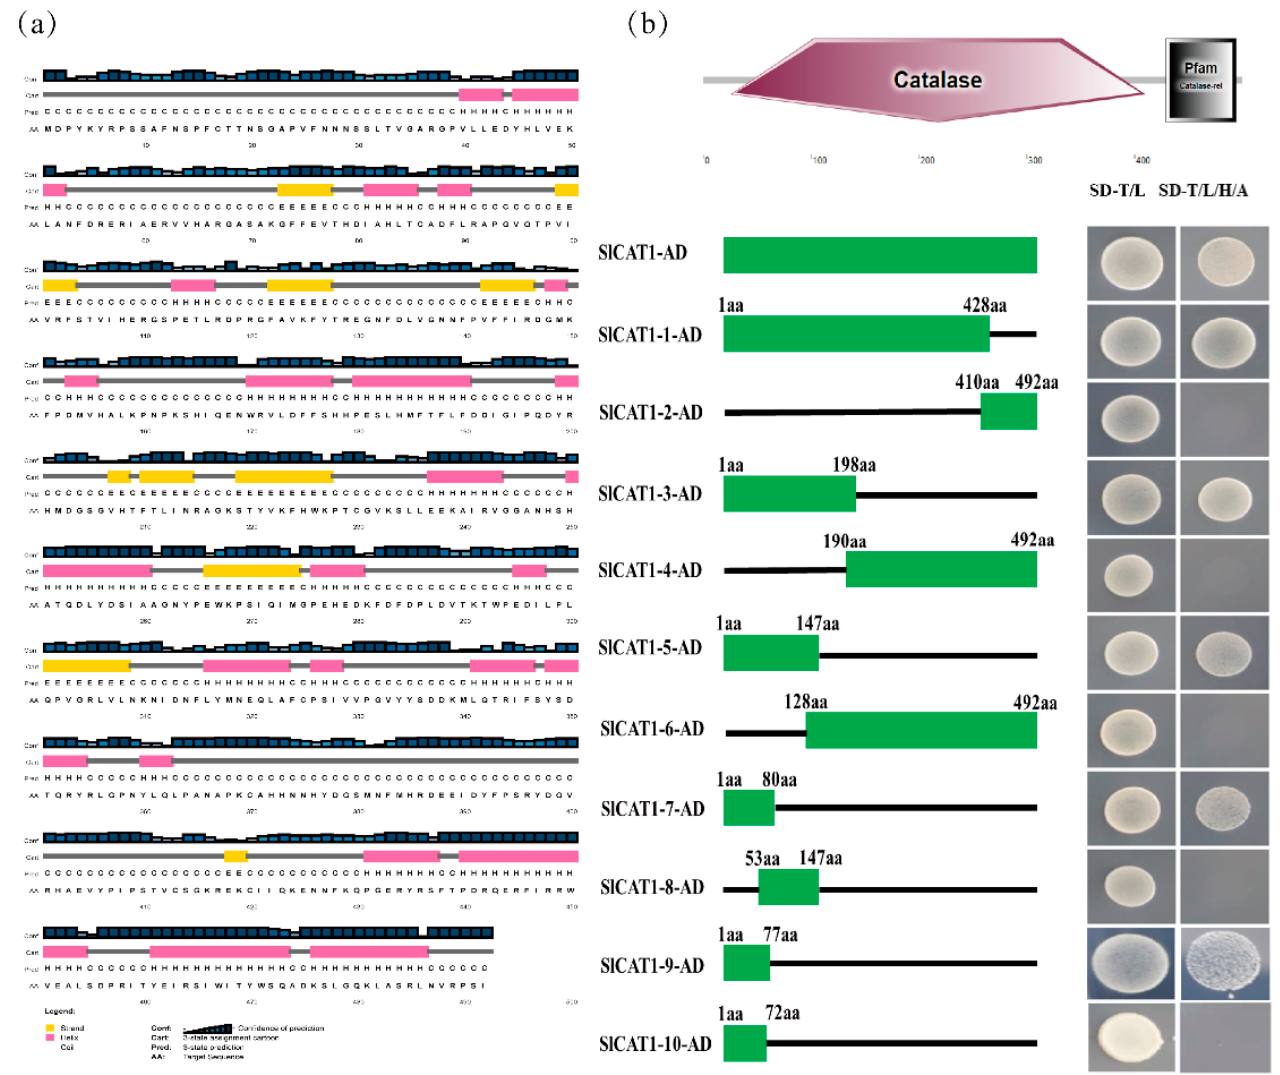
Figure 4. Verification of the functional region of the yeast cotransformation and the p27 interaction. ( a ) Prediction of the secondary structure of SlCAT1. ( b ) Prediction of the SlCAT1 domain, and Y2H was used to verify the interaction between p27 and the SlCAT1 deletion mutants.